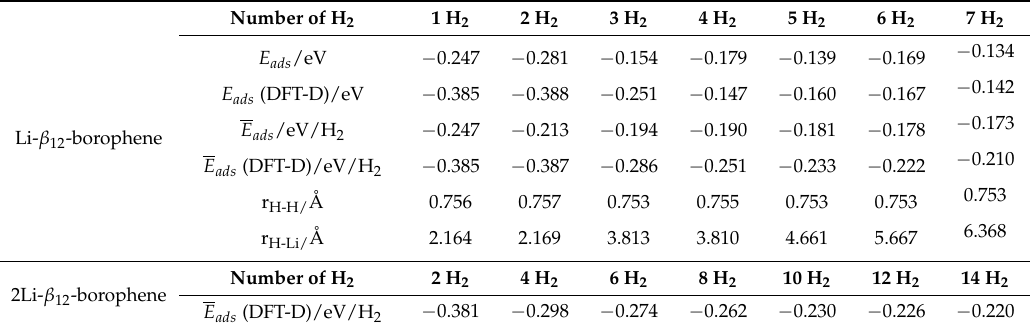
Table 1. The adsorption energy, average adsorption energy, the distance between H and H (r H-H ), the distance between H and Li of Li- β 12 -borophene system (r H-Li ). Number of H 2 1 H 2